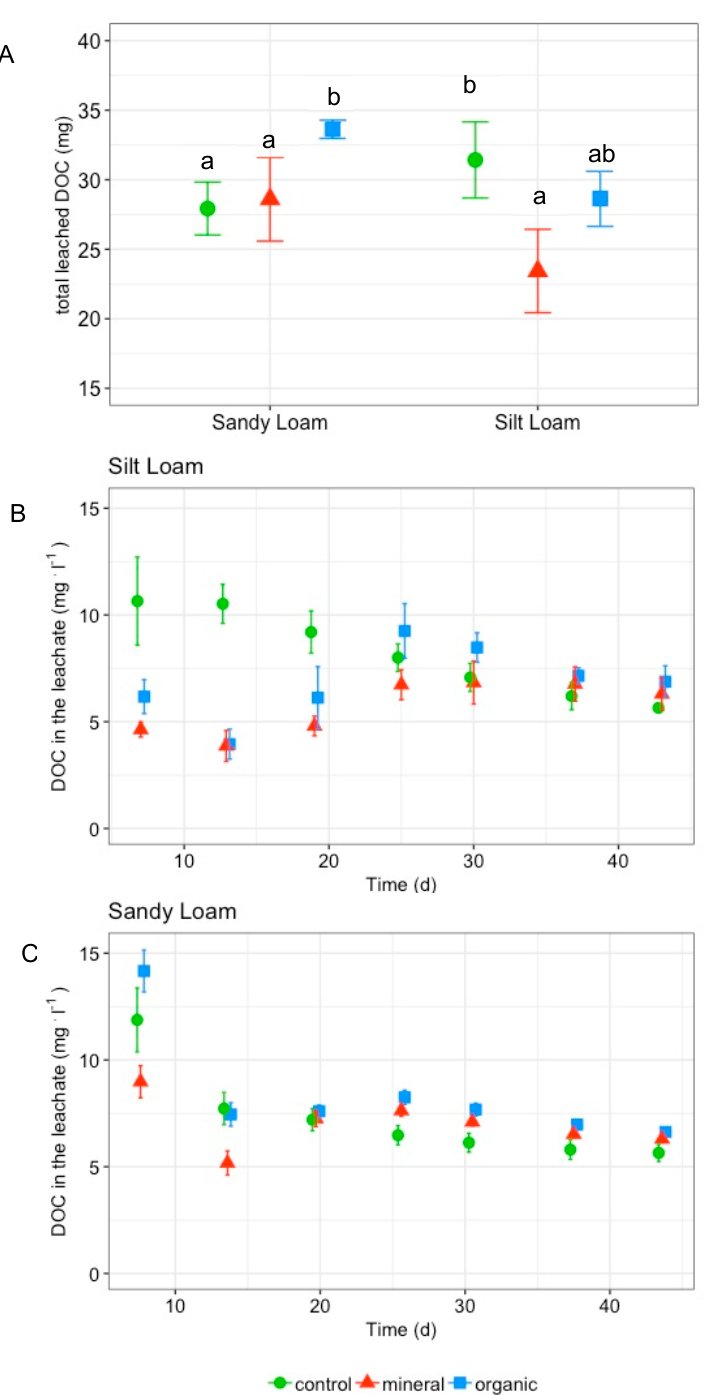
Figure 1. Mean ( ± standard deviation; SD) dissolved organic carbon (DOC) in the soil leachate: ( A ): Mean ( ± SD) total DOC amount: a summation of all time series within each treatment (left: sandy loam; right: silt loam); statistical significance of di ff erence between treatments within the soil textures are indicated with letters (Tukey; p ≤ 0.05; Silt loam: n = 21, sandy loam: n = 28). ( B , C ): Temporal response curve of the mean ( ± SD) DOC concentration in the soil leachate percolating through silt loam (( B ), n = 3) and sandy loam (( C ), n = 4); Shapes indicating di ff erent fertilizer application: control (circle); mineral (triangle) and organic (square).